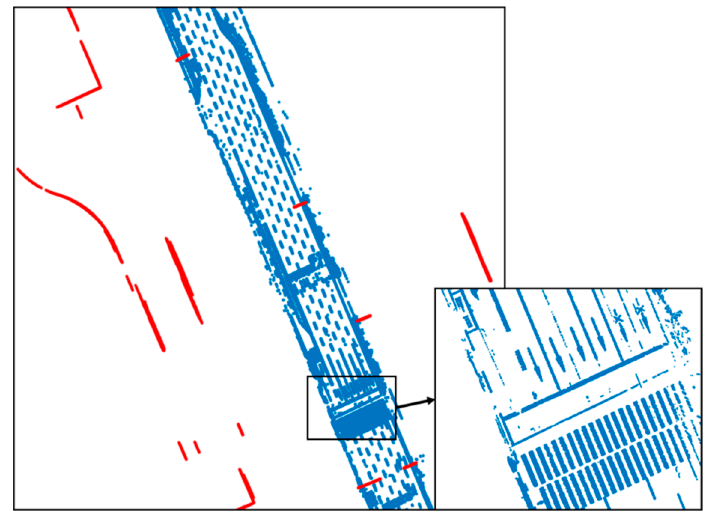
Figure 11. Road-marking and vertical structure extraction results.